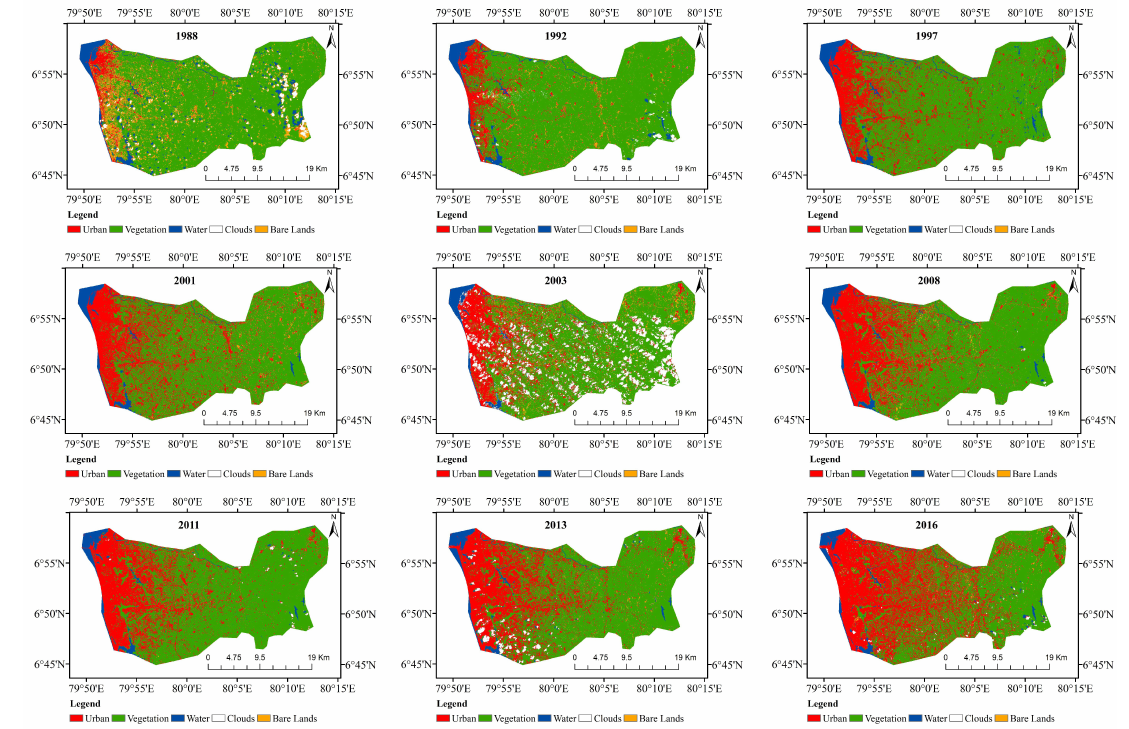
Figure 4. The results of classification using random forest (RF) in Colombo between 1988 and 2016.